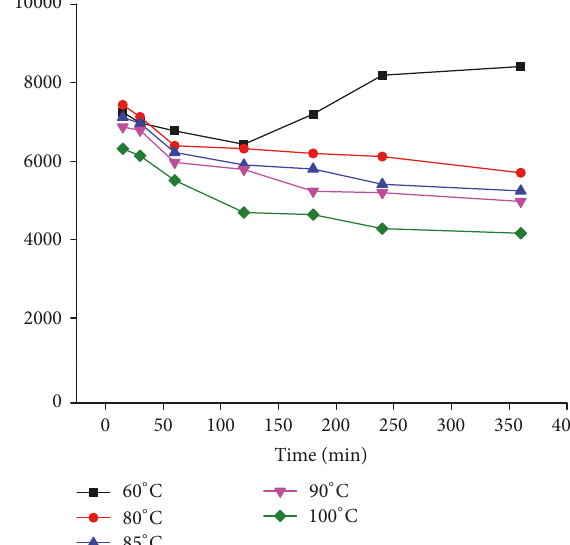
Figure 3: Springiness changes during thermal processing. Figure 4: Hardness changes during thermal processing.